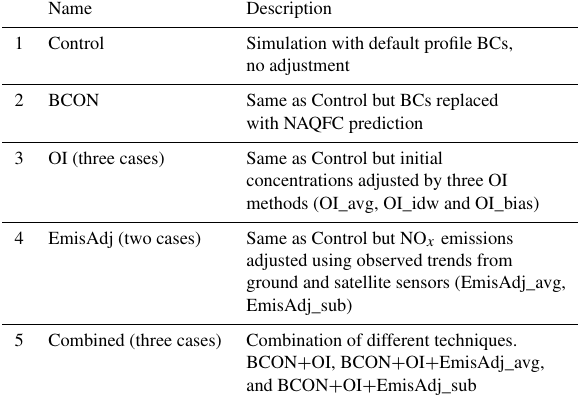
Table 1. Model adjustment and simulation design for the 3km fore- casting system